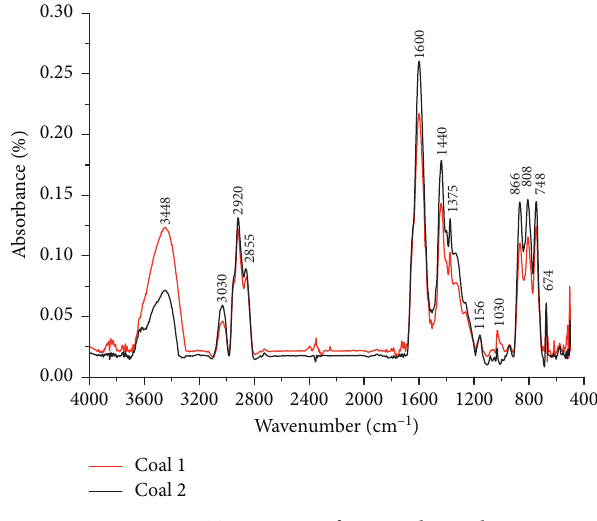
Figure 3: FTIR spectra of two coal samples.